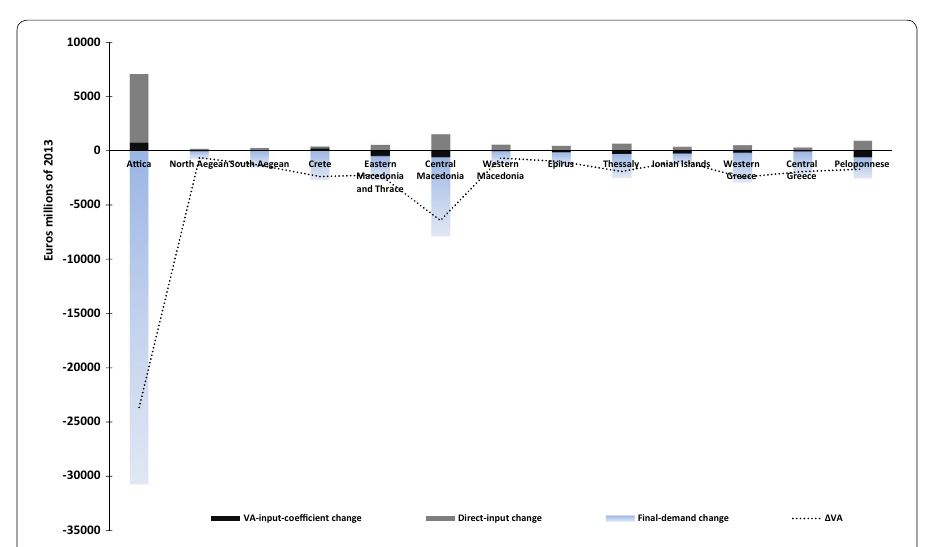
Fig. 3 Driving forces of regional income: Greece,